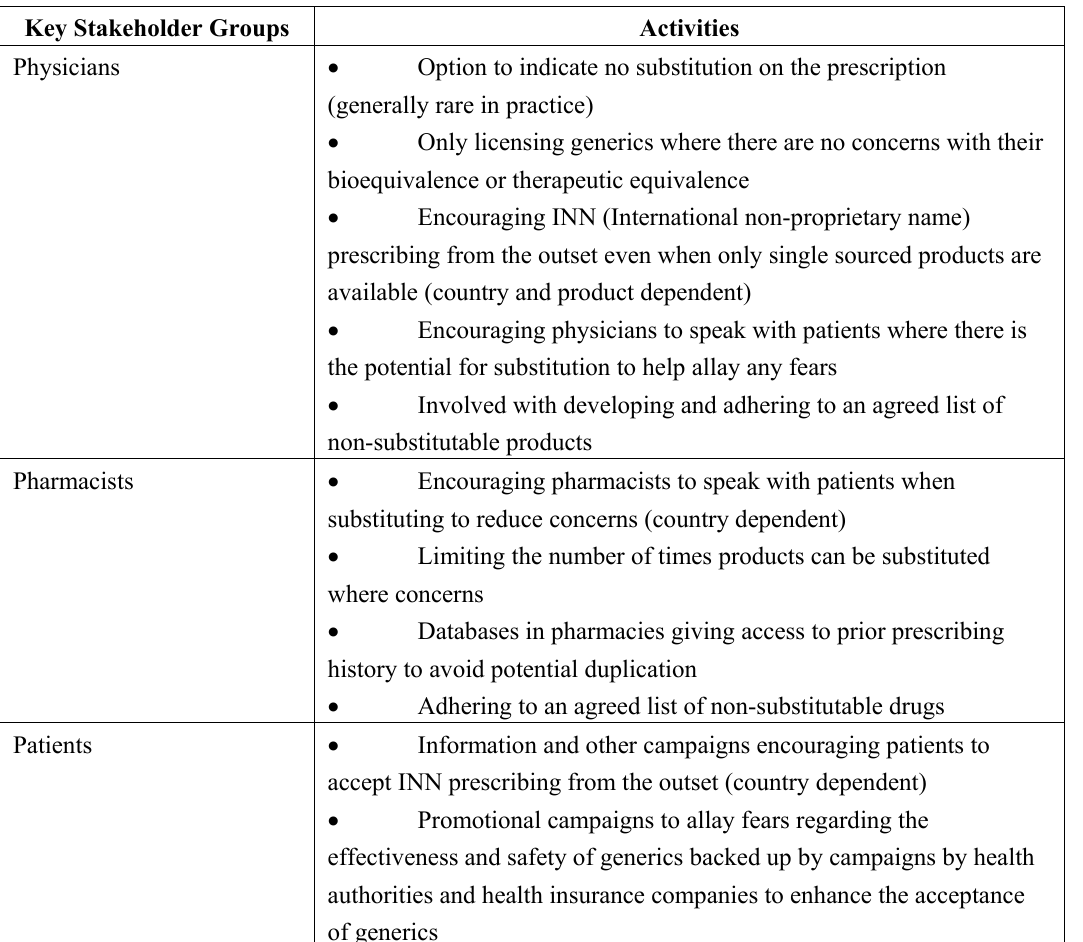
Table 4. Health Authority and Health Insurance approaches to address patient and physician concerns with generics including potential